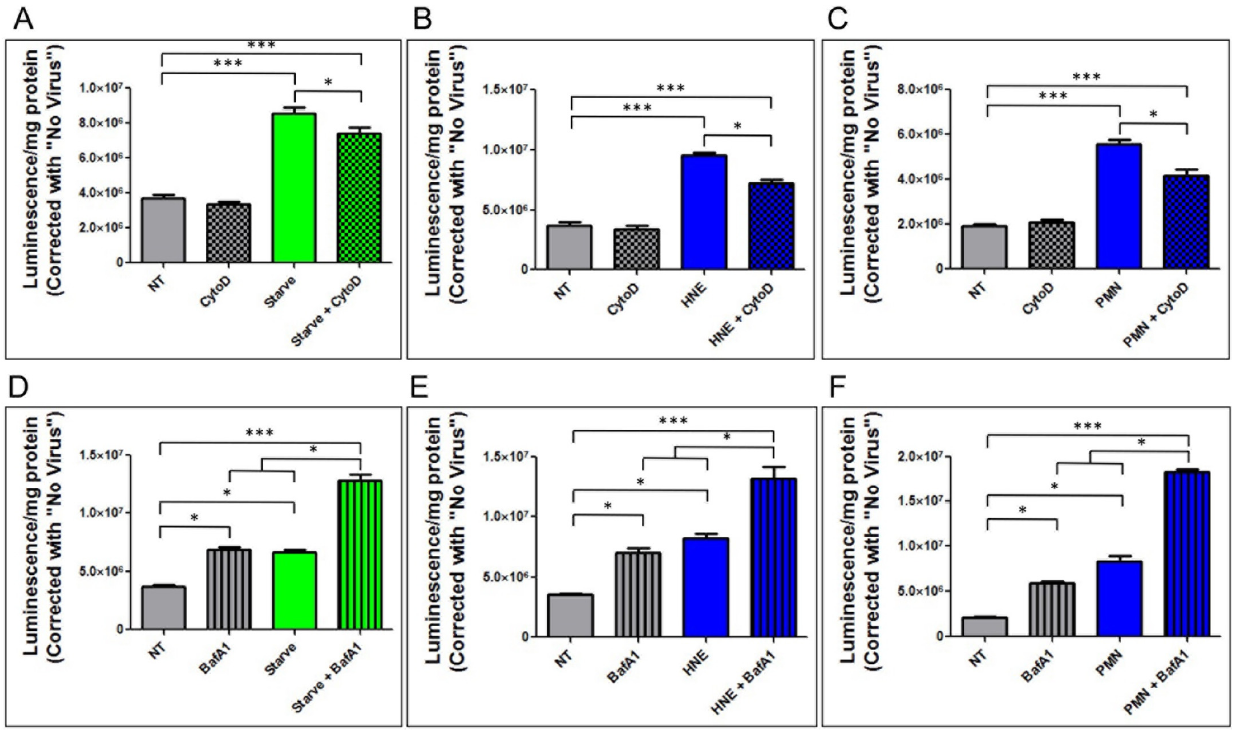
Figure 6. Cytochalasin D partially ablates and bafilomycin A1 further exacerbates enhancement of epithelial AdV5 transduction. MDCK-CAR Ex8 cells were either ( A ) exposed to HBSS starvation and then treated with cytochalasin D before treatment with ( B ) HNE or ( C ) PMN. MDCK-CAR Ex8 cells were then either ( D ) exposed to HBSS starvation and concurrently treated with bafilomycin A1 or treated with bafilomycin A1 and then subsequently treated with ( E ) HNE or ( F ) PMN. In all cases, the MDCK-CAR Ex8 cells were subsequently infected with AdV5-LacZ. Beta-galactosidase activity assay was performed the following day to measure AdV5 transduction. Error bars represent SEM from 3 independent experiments each performed in quadruplicate. * p < 0.05, *** p < 0.001 by one-